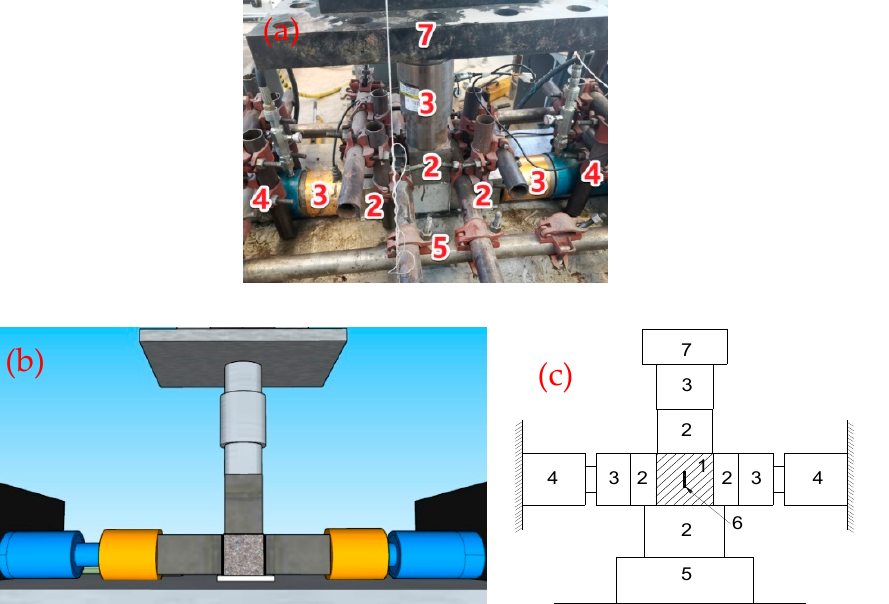
Figure 1. Schematic diagram of loading. ( a ) Experimental setup diagram. ( b ) 3D schematic ( c ) Plan schematic. Note: 1 — engineered cementitious composite (ECC) cubic specimen; 2 — Force transmis-